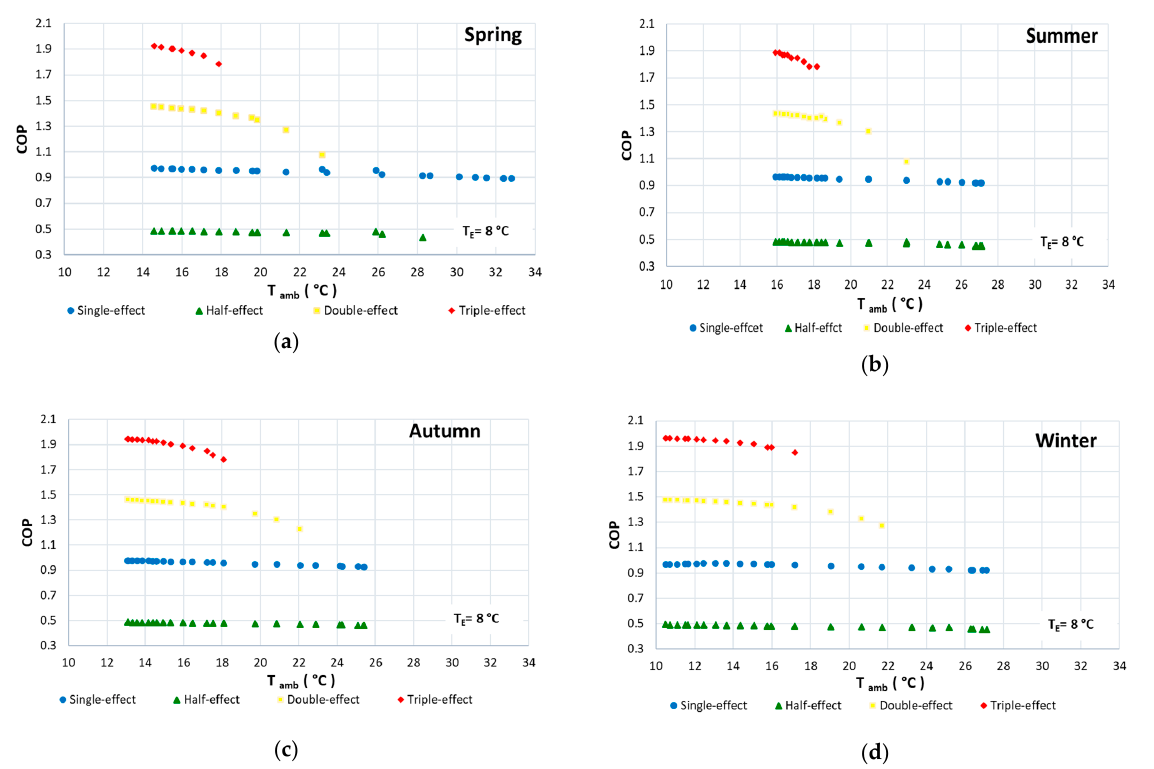
Figure 13. COP as a function of the Tamb for each absorption system for ( a ) Spring, ( b ) Summer, ( c ) Autumn, and ( d ) Winter. ( c ) Autumn, and ( d )